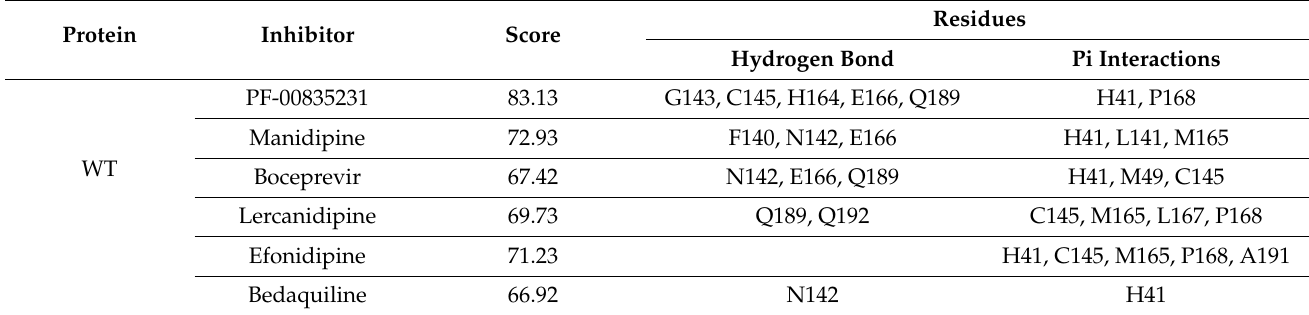
Table 1. The binding details of all compounds against the WT Mpro.